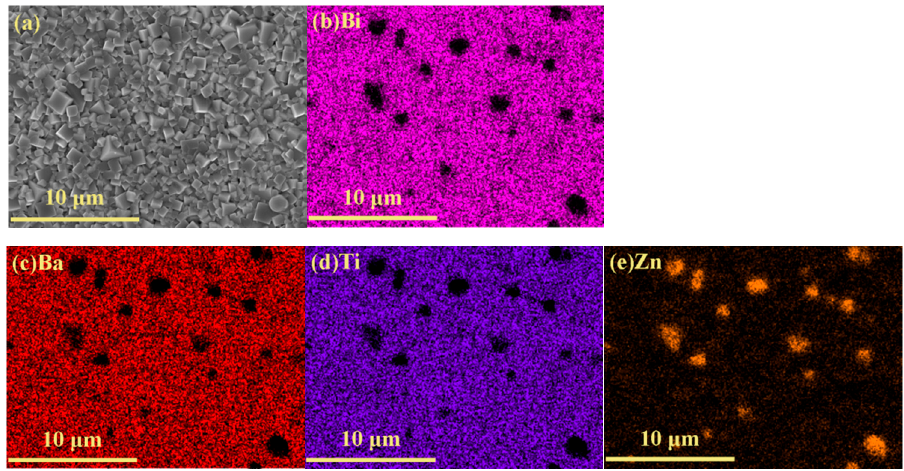
Figure 2. Elemental mapping on the surface of BNKT-BT-0.3ZnO composites, ( a ) morphology of scanning micro area, the distribution of ( b ) Bi, ( c ) Ba, ( d ) Ti, and ( e ) Zn.